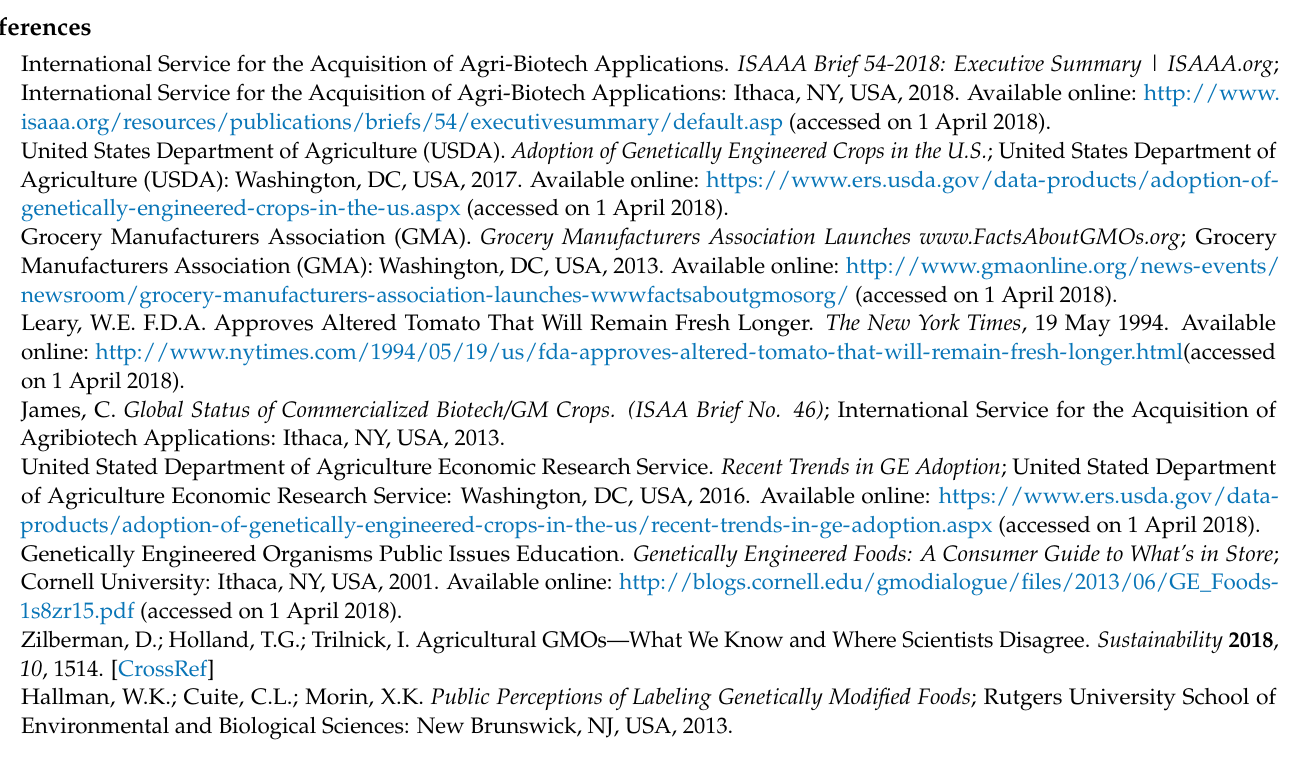
As noted above, prior literature suggests that knowledge of a risk [60] and affective judgements about GM technology, including moral assessments [50,61], may influence risk and benefit perceptions. We collected these data as control variables in an effort to isolate the effect of our experimental conditions. Standardized coefficients are reported in-text, as the independent variables had different measurement scales. Both the standard- ized and unstandardized coefficients are available in Table